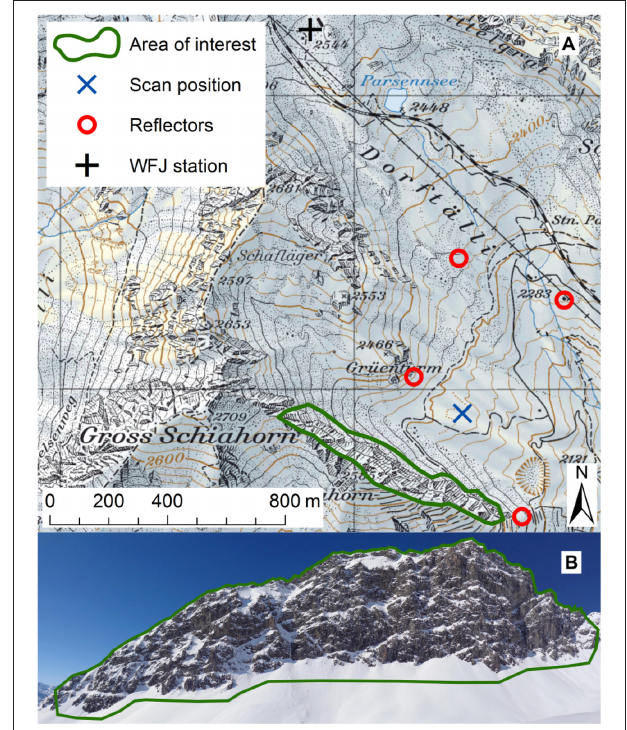
FIGURE 1 | (A) Map of the measurement location showing the rock face, the scan position and the reflector locations. The map also shows the location of the meteorological reference station Weissfluhjoch (WFJ). (B) View of the rock face from the scan position. The extent of the area of interest is sketched in approximately. The Schiahorn is located in eastern Switzerland just to the north of Davos. Base map reproduced by permission of swisstopo